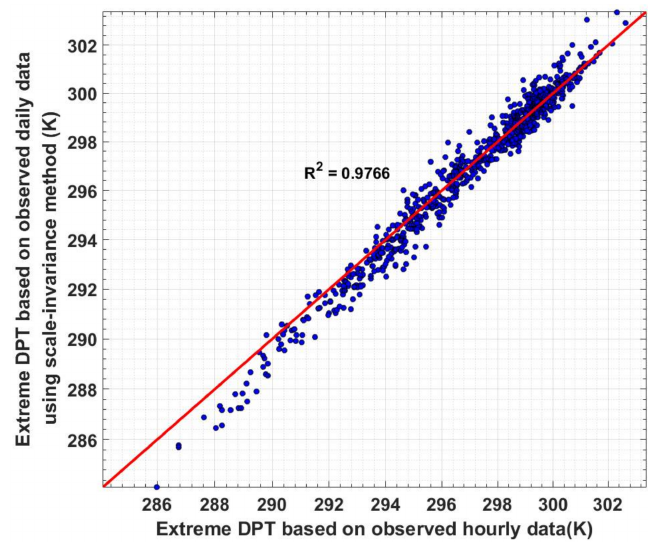
Figure 5. Scale exponents with respect to various orders of moment at Seoul station in the first half of August.